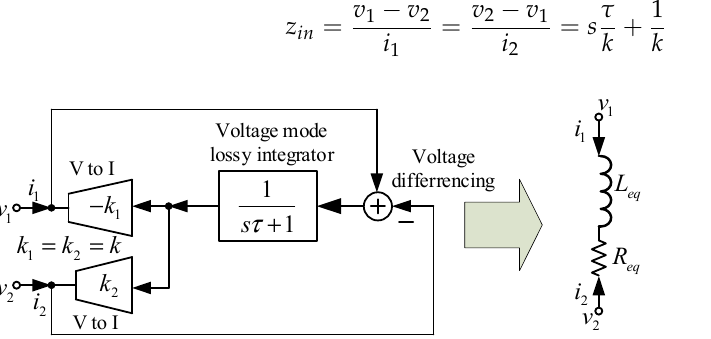
v − v + v + v − Figure 14. The floating lossless inductance simulator based on VD-DIBAs. Equation (4) shows that the circuit exhibited in Figure 14 simulates the impedance of the floating lossless inductance simulator, where its equivalent inductance value is given